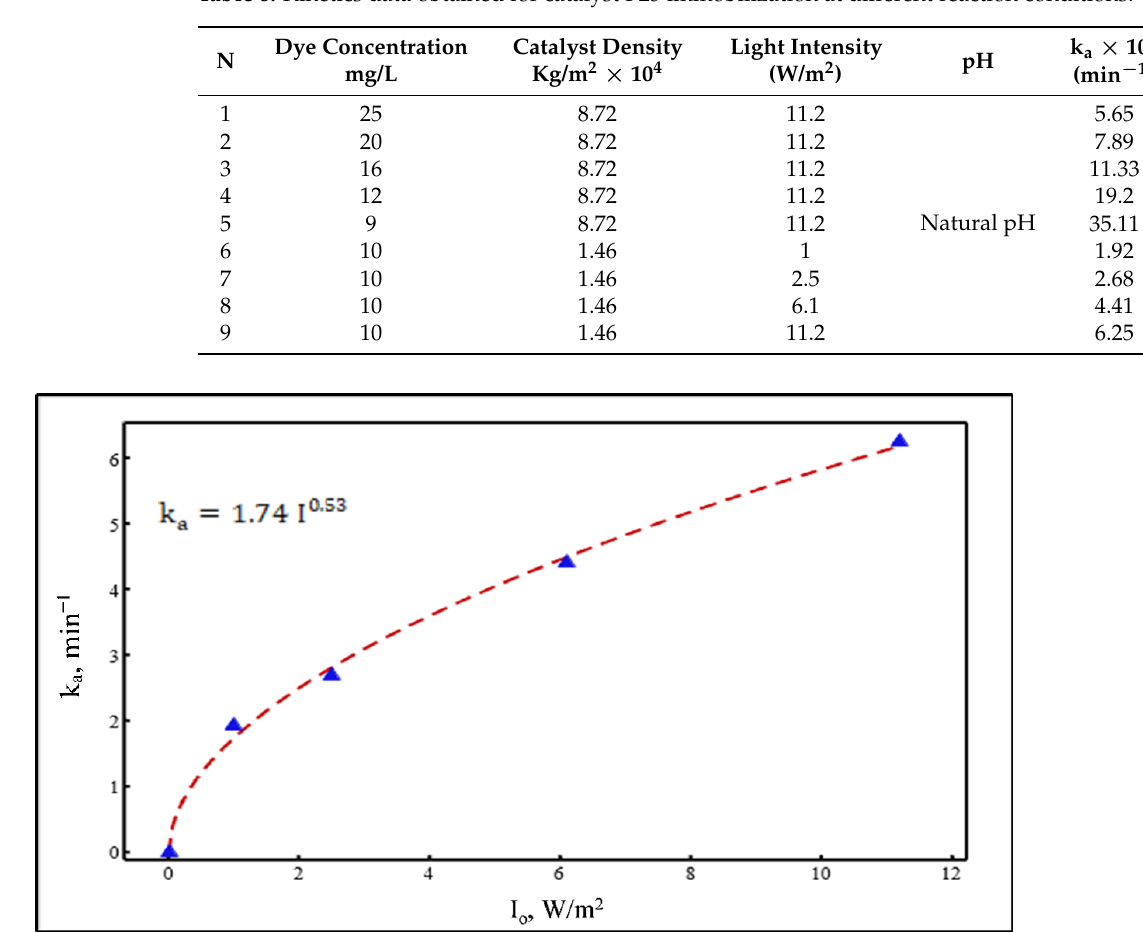
Figure 17. Non-linear regression of k a values vs. different light intensities. Table 8. Kinetics data obtained for catalyst P25 immobilization at different reaction conditions.